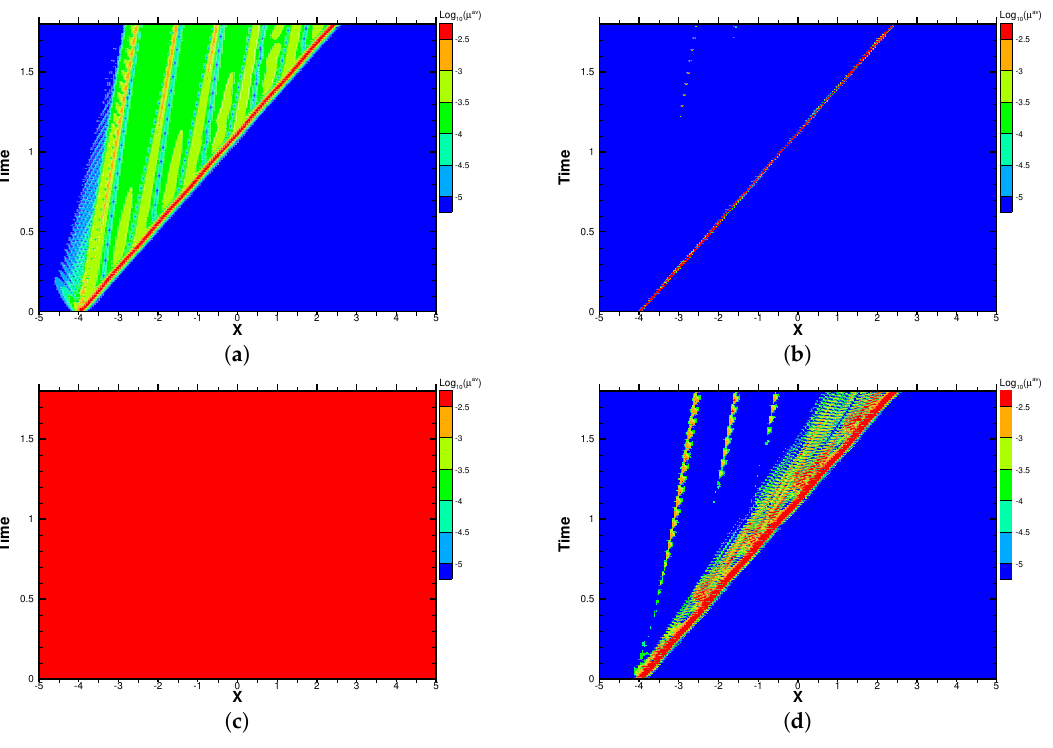
Figure 12. Temporal history of artificial viscosity for the one-dimensional Shu–Osher problem with 200 P2 elements for t ∈ [ 0,1.8 ] . ( a ) DB; ( b ) MDH; ( c ) MDA; ( d )